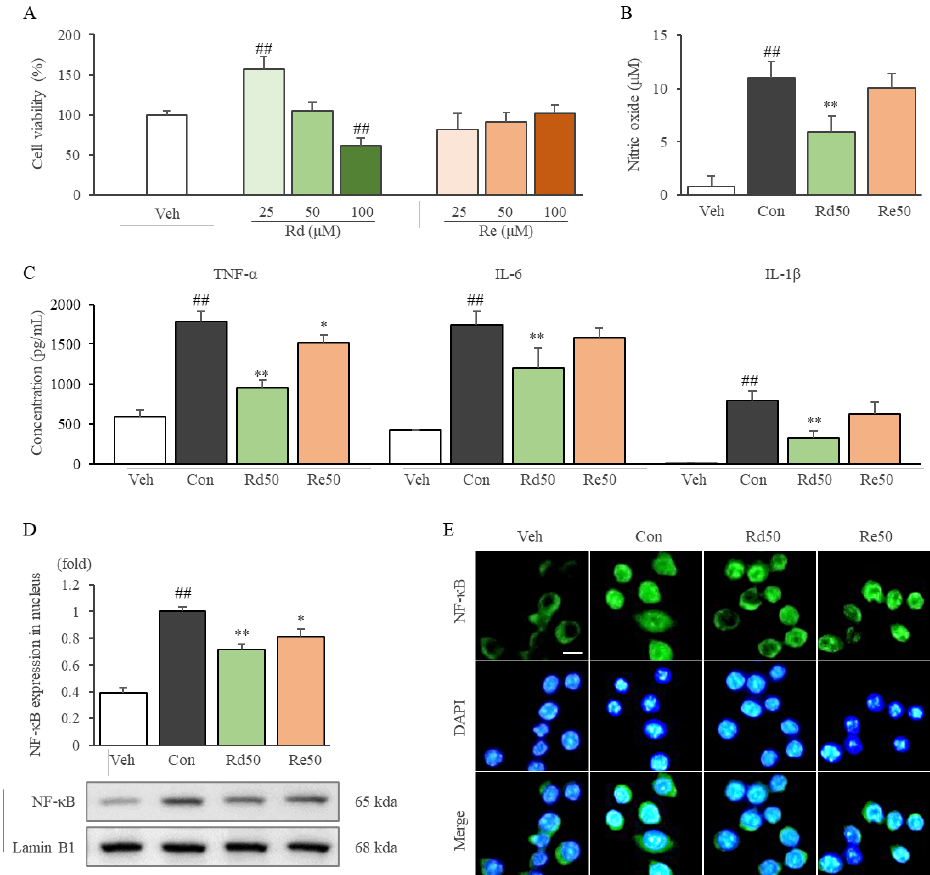
Figure 6. Effects of ginsenoside Rd on the production of inflammatory cytokines and nitric oxide, and nuclear translocation of NF- κB in LPS -stimulated RAW264.7 cells. A WST-8 assay was conducted to evaluate the viability of cells treated with ginsenoside Rd and Re ( A ). Nitric oxide ( B ) and proinflammatory cytokine ( C ) levels were analyzed in the LPS-stimulated-cell supernatant. After 2 h of LPS stimulation, nuclear translocation was evaluated by Western blot ( D ) and immunofluorescence staining under 200× magnification ( E ). Samples were grouped according to treatment: vehicle (Veh), control (Con), 50 μM ginsenoside Rd (Rd50), and 50 μM ginsenoside Re (Re50). The data are presented as the mean ± SD. ## p < 0.01 compared with the vehicle group; * p < 0.05, ** p < 0.01 compared with the control group.